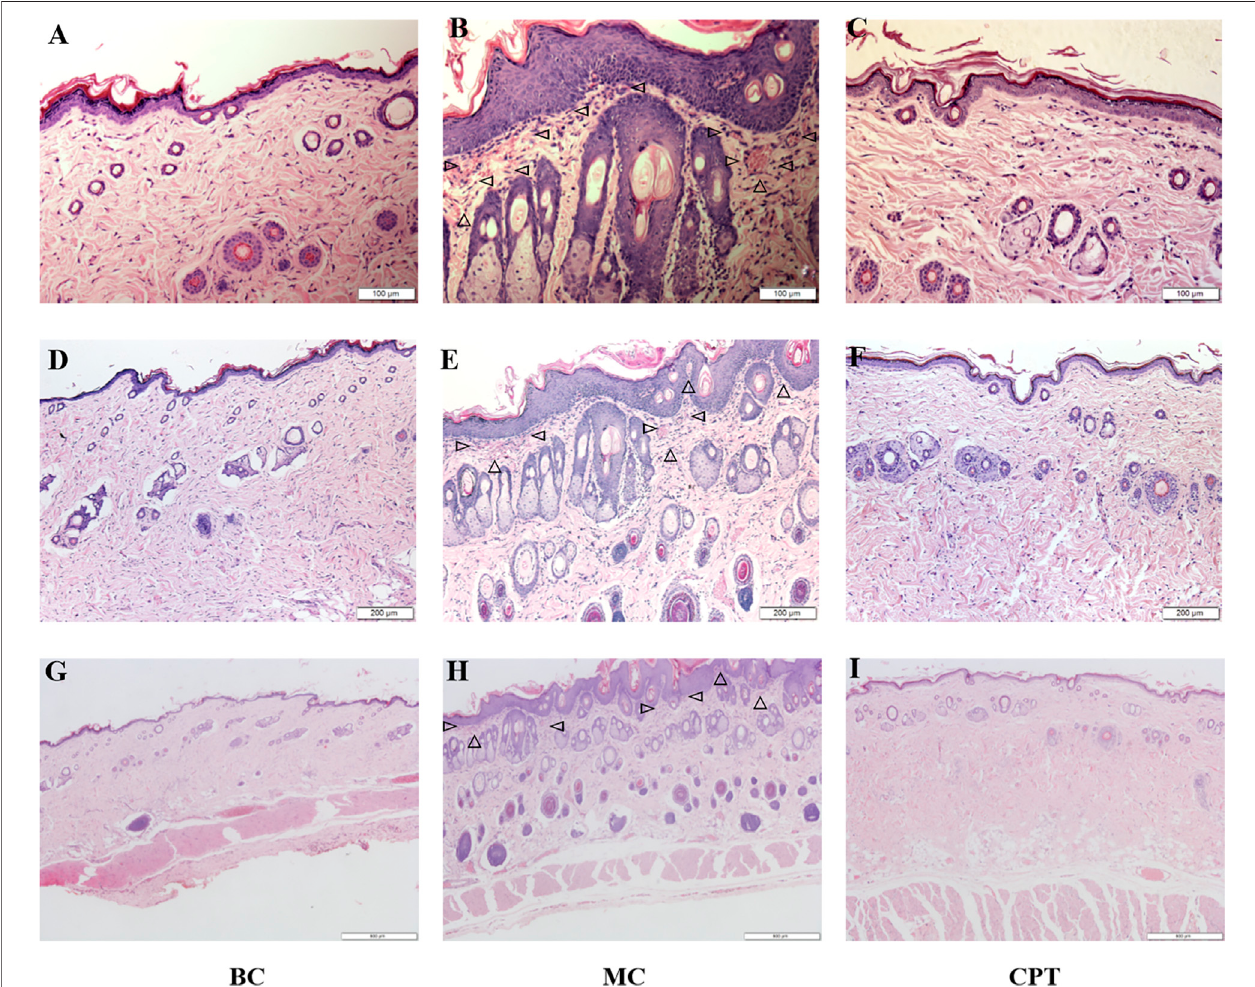
FIGURE 1 | The skin tissues of CPT treatment in acne (HE, magni fi cation × 200, × 100 and × 40) (A) , (B) and (C) : magni fi cation × 200 (100 μ m) (D) (E) and (F) : magni fi cation × 100 (200 μ m) (G) , (H) and (I) : magni fi cation × 40 (500 μ m) (A) , (D) and (G) : BC (blank control) group; (B) , (E) and (H) : MC (model) group; (C) , (F) and (I) : CPT (treatment) group; the triangles in MC group represent neutrophilic in fl ammatory cell in fi ltration.